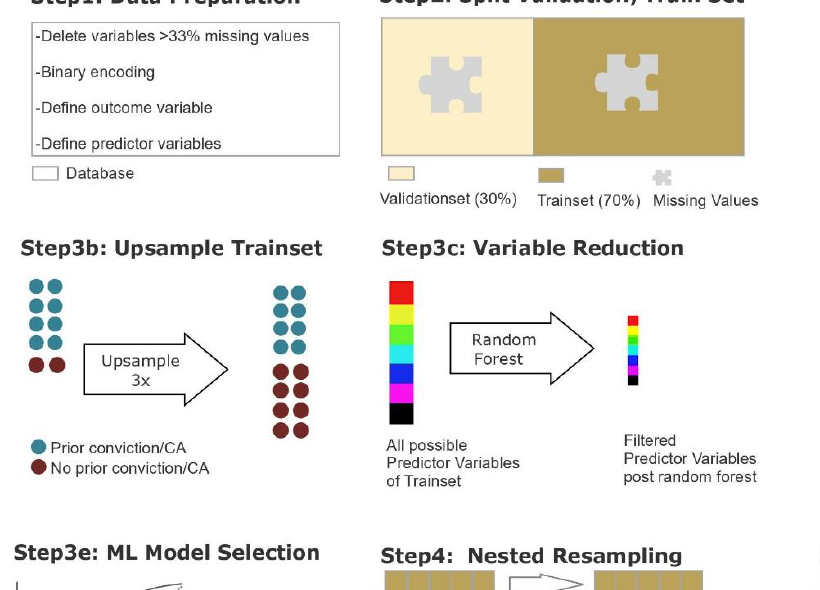
Table 2. Machine Learning Models and their performance in nested cross-validation